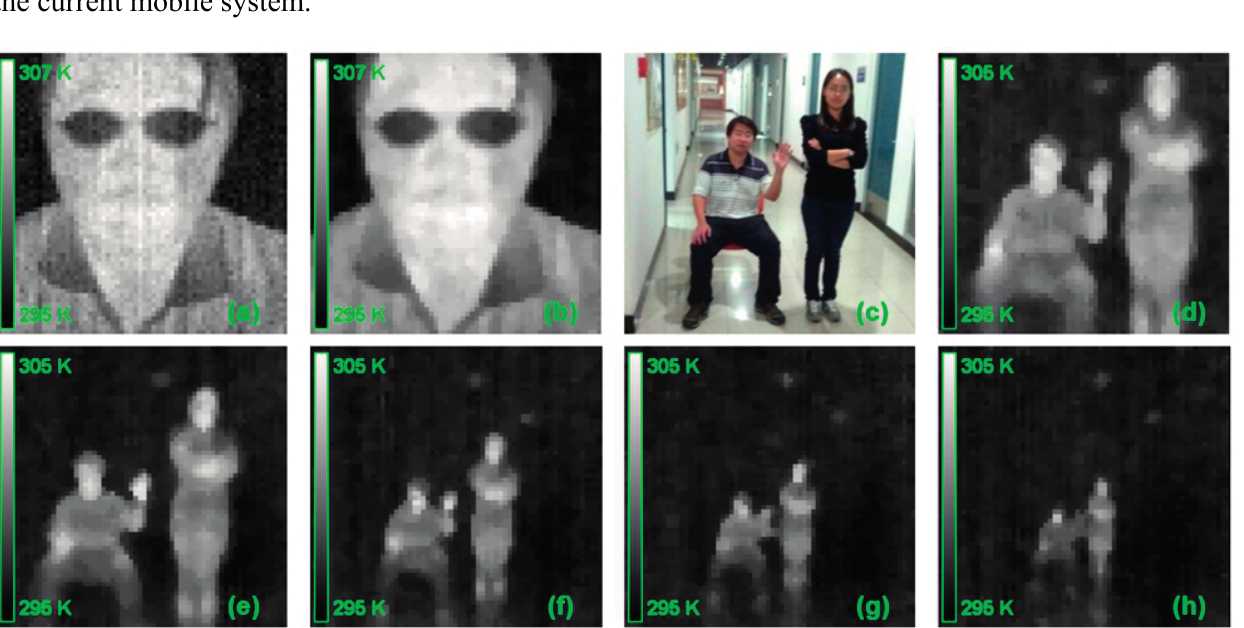
Figure 6. The performance of MTIS. ( a ) The raw thermal image of human face; ( b ) the corrected result of ( a ); ( c ) two people in different poses; and ( d – h ) the thermal image of (c) at 2, 3, 4, 5, and 6 m from the